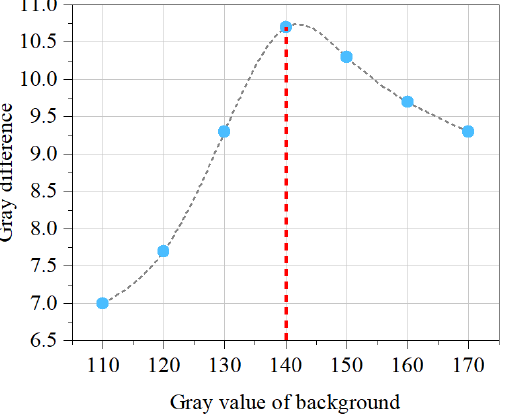
Figure 11. Relationship between background grayscale and grayscale difference.